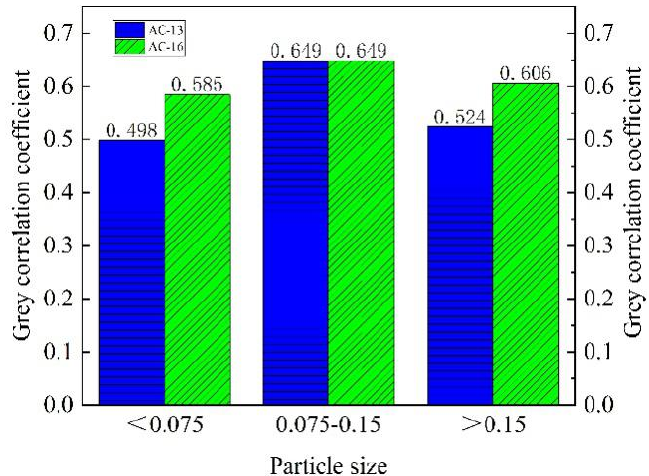
Figure 12. Grey correlation analysis results.